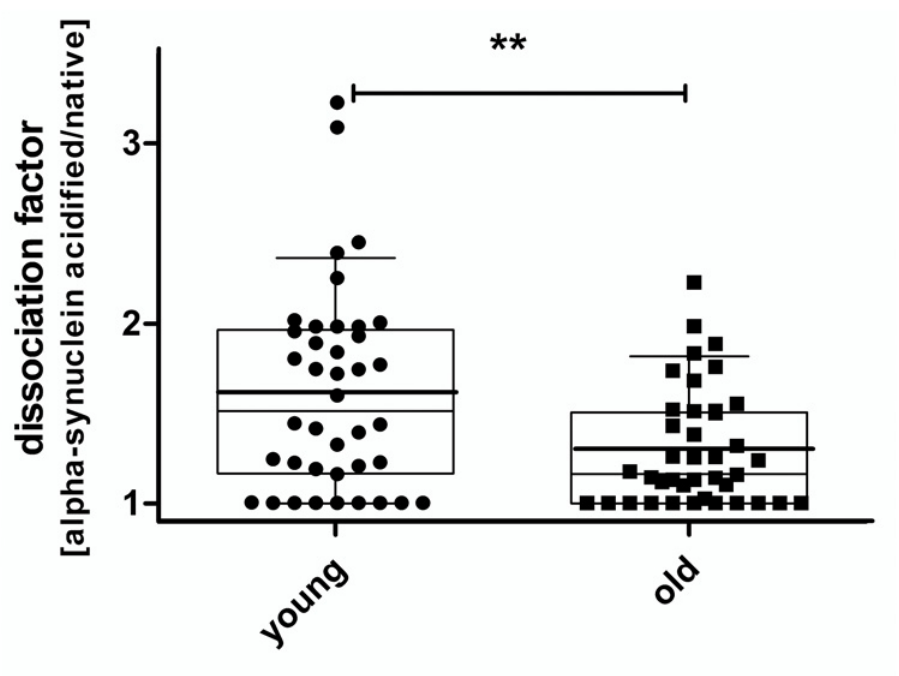
Fig 6. Dissociation factor after plasma acidification young vs. old. Box plots * of dissociation factors, calculated by dividing the acidified and native plasma alpha-synuclein concentration of each individual sample. Lower dissociation factors were observed in older individuals, very significant by Mann Whitney test, p =